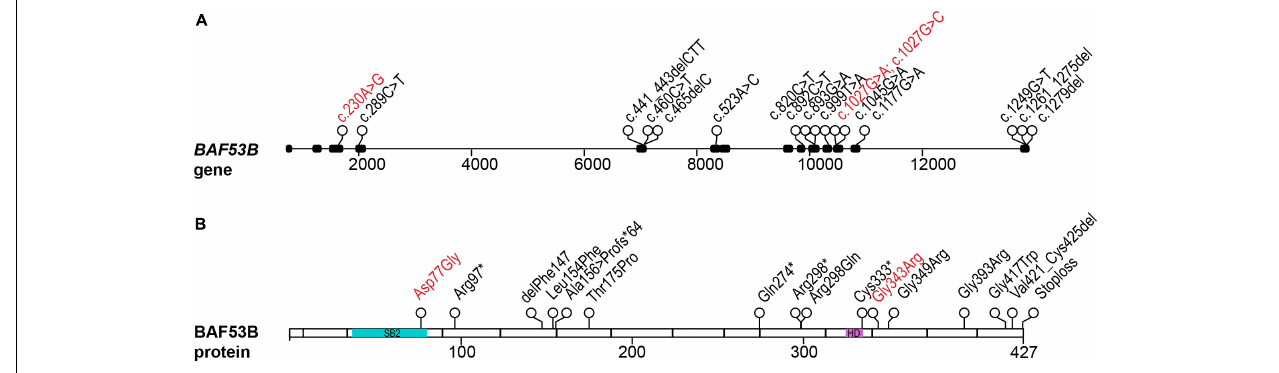
FIGURE 1 | Patient mutations in the BAF53B gene. (A) The BAF53B gene locus. Each circle represents a nucleotide position where a mutation was found by whole exome sequencing. Black boxes represent exons and nucleotide position of the mutation is in the coding sequence (c.). Scale is in base pairs. (B) The BAF53B protein. Each circle represents an amino acid position where a mutation was found by whole exome sequencing. The most divergent regions of BAF53B, SB2, is located in amino acids 39–82 (blue). The HD, predicted to form protein-protein interactions with other nBAF subunits, is located in amino acids 323–333 (purple). Scale is in amino acids. Recessive mutations are in black text and dominant mutations in red